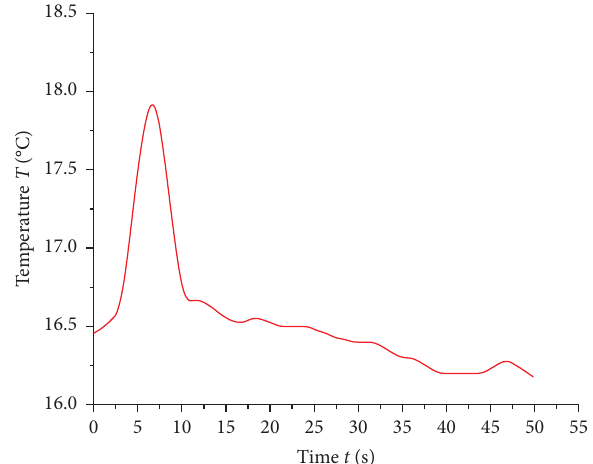
Figure 7: Temperature evolution of composite gels under rapid monotonic tension.